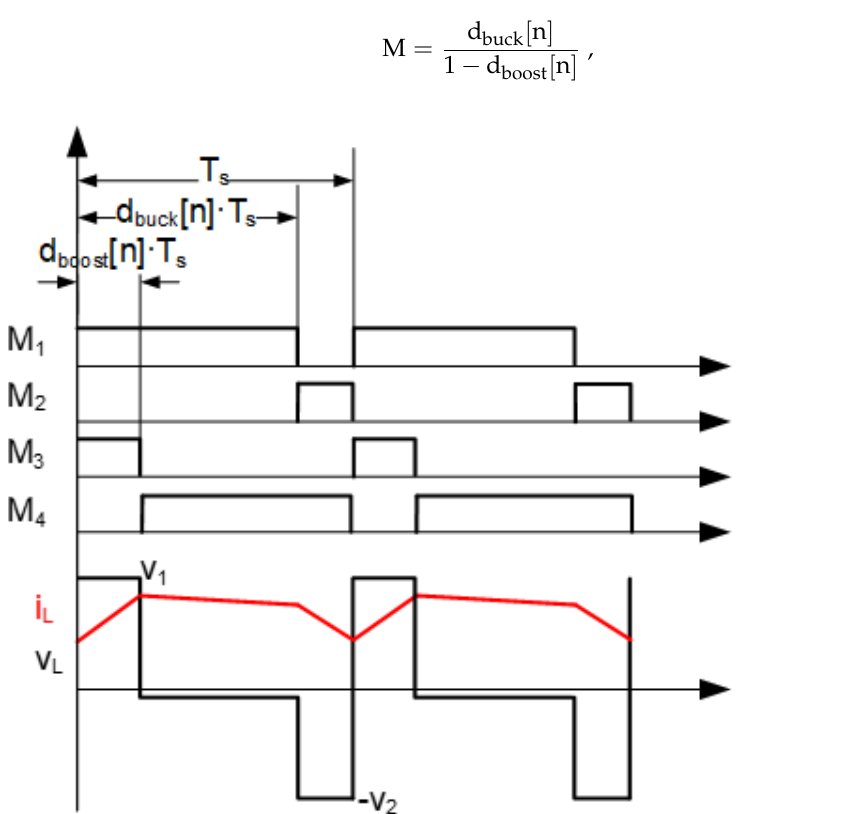
Figure 6. Main operation waveforms of the 4SBB in Buck+Boost mode.